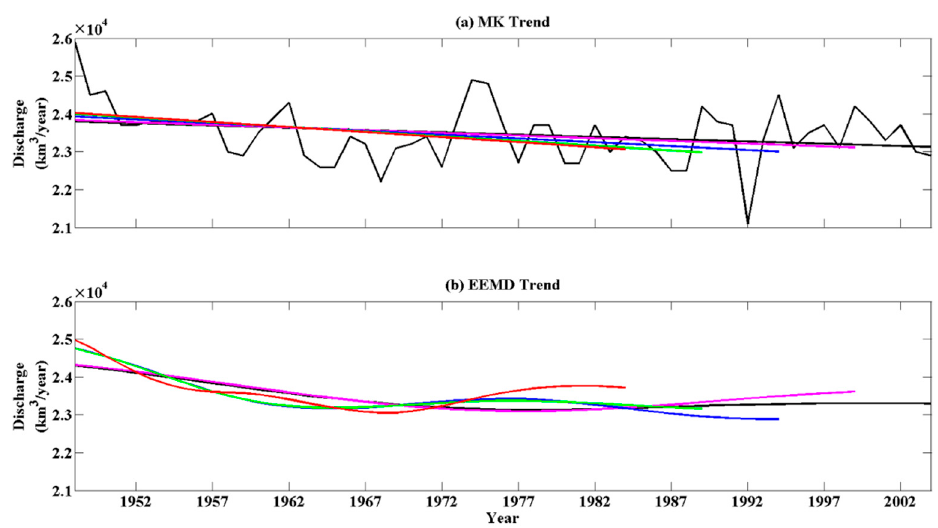
Figure 6. Sensitivity of the estimated trends to the same starting year (1948) but different ending year of global runoff data. Different colors represent the estimated trends for ending times of 1979, 1984, 1989, 1994, 1999, and 2004. The estimated trends are shown in ( a ) for the MK method and ( b ) for the EEMD method.